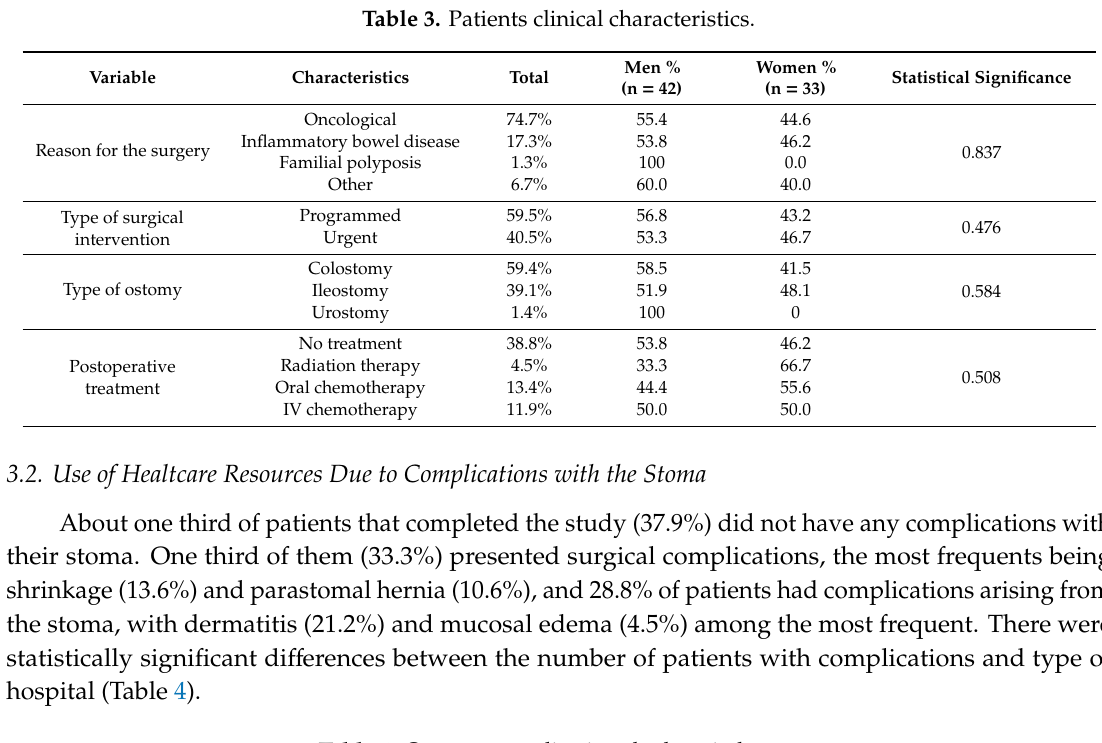
Table 4. Ostomy complications by hospital